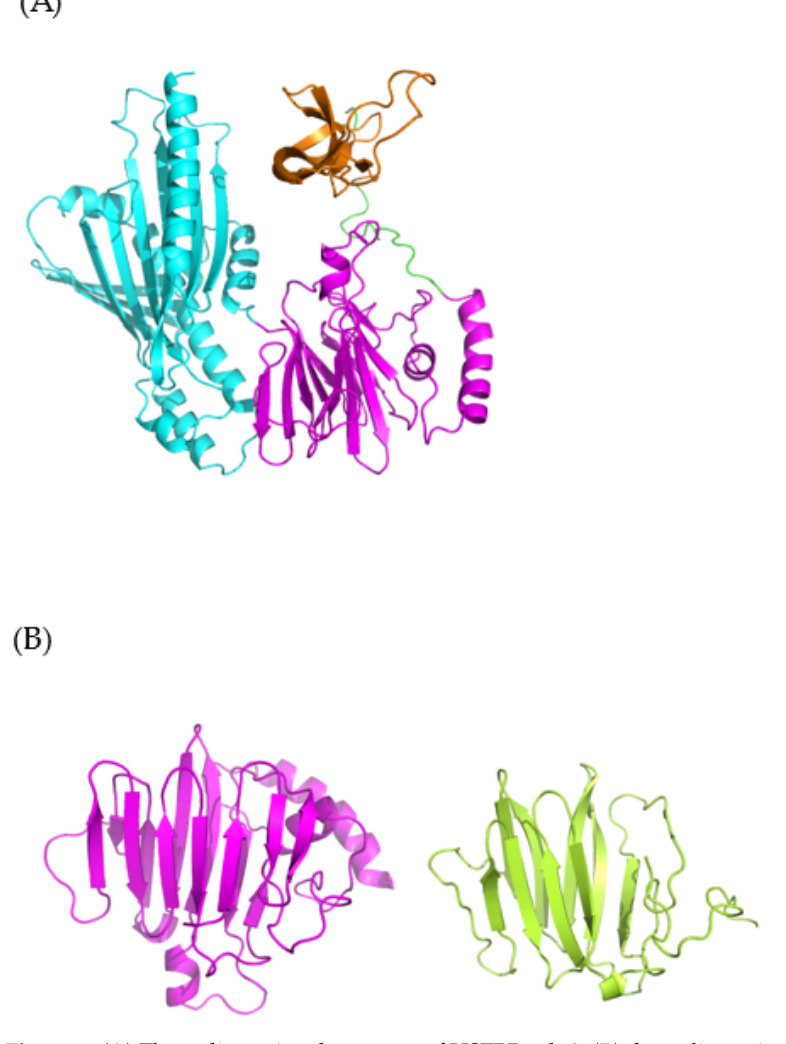
Figure 5. ( A ) Three-dimensional structure of HSTBP sub-2; ( B ) three-dimensional structures of vWF type D domain of HSTBP sub-2 (left) and TfVWF